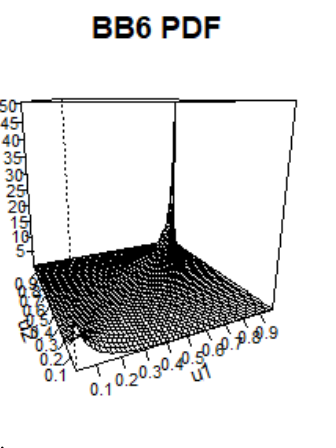
Figure 14. BB6 c.d.f. and p.d.f. with θ = 1.59 and δ =